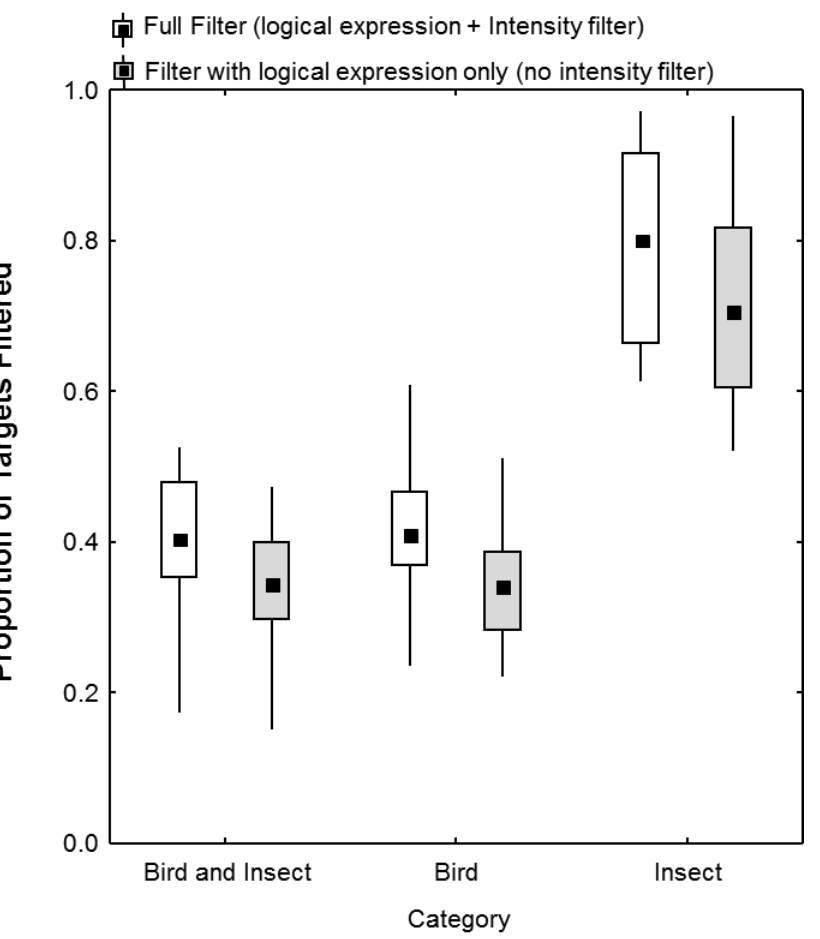
Fig. A1.2 . The proportion of tracked targets removed by the use of Full and Partial filters compared to the same data without filters. Full Filter includes the logical expression and intensity filter – Eq 2 – and Partial Filter includes only the logical expression filter – Eq. 1. Data represents 12 nights of sampling where 15 min periods of the night when the targets were predominantly insect samples (dusk), predominantly bird samples (middle of night in cooler weather) and the bird and insect samples (period between dusk and midnight). Data was collected at the Dokie I Wind Energy Project from 2008 to 2012. Filtering removed a greater proportion of targets under periods of predominantly insect traffic, suggesting the Full Filter expression can reliably help reduce insect